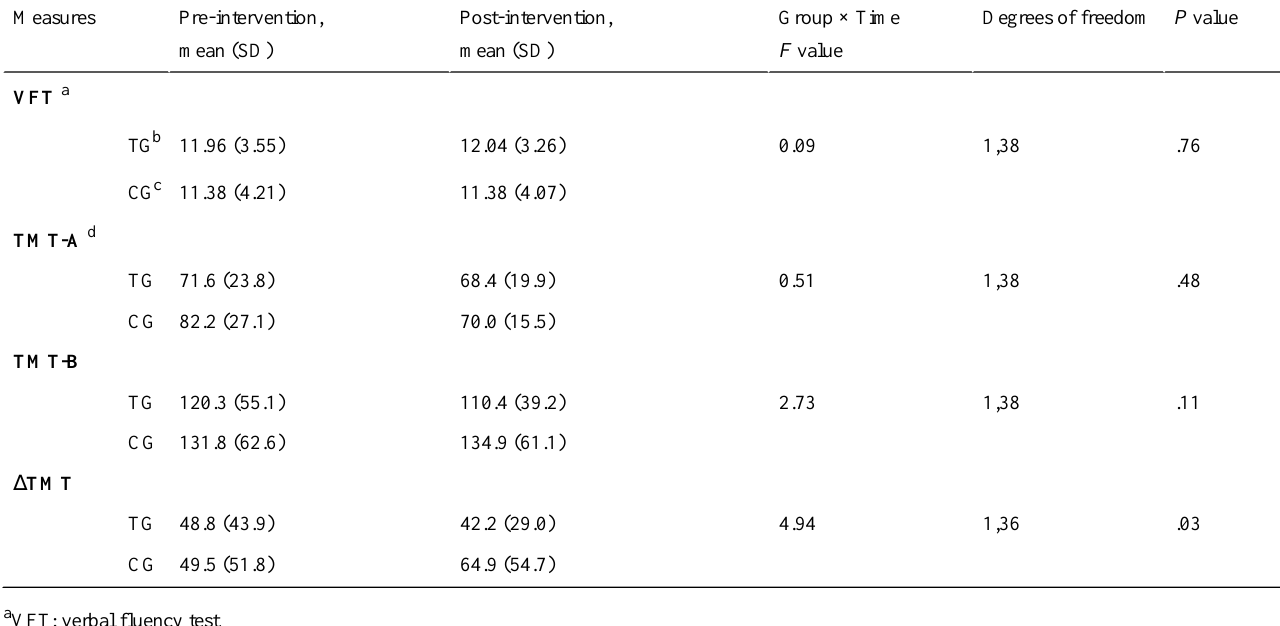
P valueDegrees of freedomGroup × Time